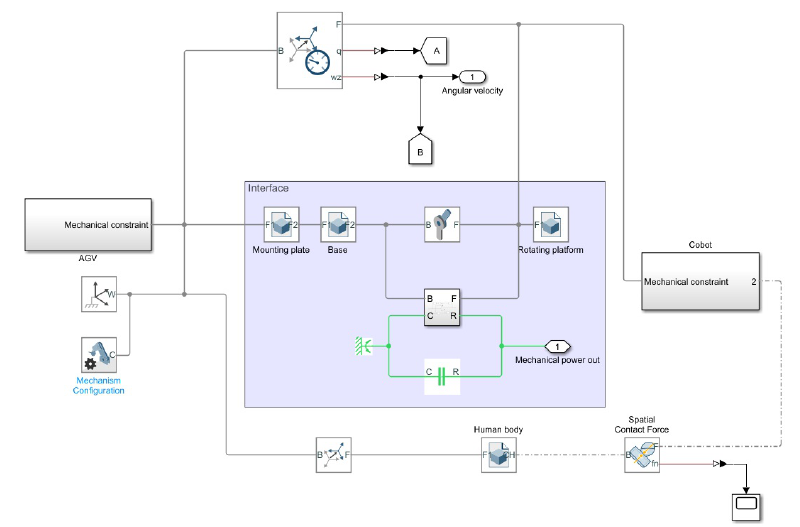
Figure 19. Simscape modeling: mechanical system with